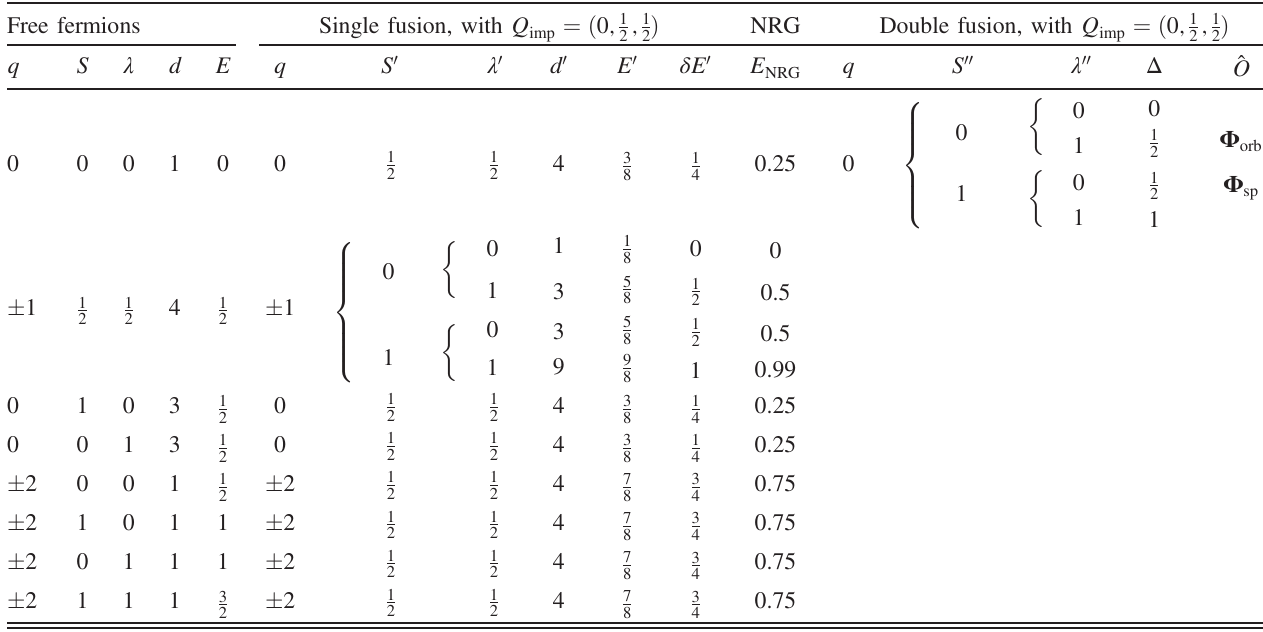
TABLE V. Fusion table for the NFL fixed point of Ye ’ s 2soK model. It is structured just as Table II for the 3soK model, but here the free bath excitations are computed using Eqs. (A2) and Table S6 of the SM [54], and single fusion of bath and impurity degrees of freedom is performed simultaneously in the spin and orbital sectors, using SU ð 2 Þ 2 × SU ð 2 Þ 2 fusion rules (listed in Table S7 of the SM [54]). The resulting multiplets ð q; S 0 ; λ 0 Þ have energies E 0 ¼ E ð q; S 0 ; λ 0 Þ and excitation energies δ E 0 ¼ E 0 − E 0 energies, computed for ð J 0 ; K 0 ; I 0 Þ ¼ ð 0 . 1 ; 0 . 3 ; 0 Þ [Fig. 8(a)], have been shifted and rescaled such that the lowest energy is zero and the second-lowest values for E and δ E 0 match. The single fusion and NRG spectra agree very well (deviations ≲ 1% ). NRG Free fermions